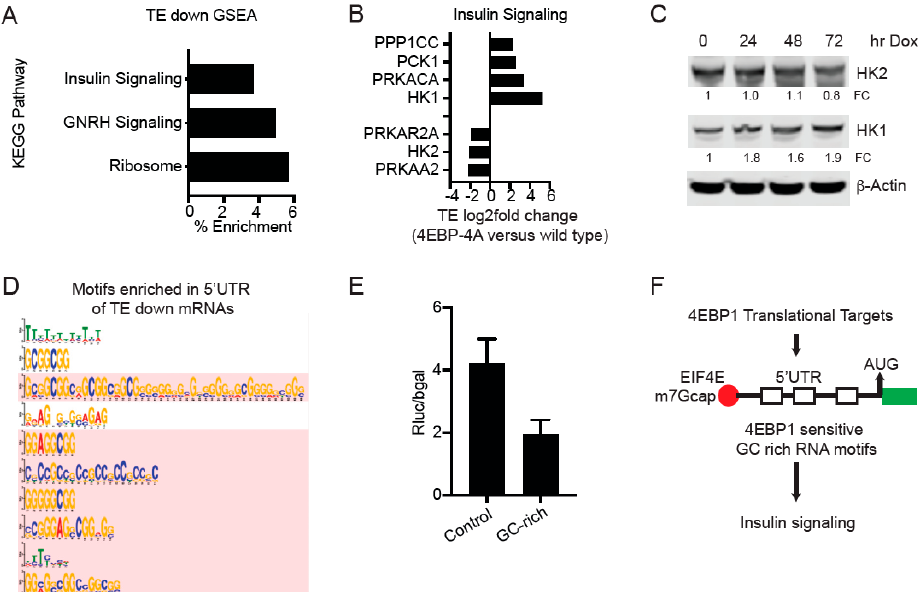
Figure 5. 4EBP1 controls the translation of genes involved in insulin signaling, glucose metabolism, and the inositol pathway. ( A ) GSEA KEGG pathway analysis of 4EBP1-dependent (TE-down) genes. ( B ) TE (log2fold change) of key genes involved in insulin signaling. ( C ) Immunoblot validation translational downregulation of HK2 and upregulation of HK1 protein in a 4EBP1-dependent manner. B-actin was used as the loading control. Quantification of respective proteins is indicated as fold change (FC) normalized to b-actin and untreated cells. ( D ). Conserved RNA motifs enriched in the 5 ′ UTR of mRNA that was downregulated in 4EBP1-4A-mutant-expressing cells compared to the background (Bkg) genes. ( E ) Luciferase assay showing relative translation activity of control (AT-rich) and GC-rich motifs in 293T cells expressing 4EBP1-4A ( n = 6, p < 0.05). ( F ) Diagram showing the regulation of 4EBP1-dependent translation through 4EBP1-sensitive RNA motifs in the 5 ′ UTR. 4EBP1 regulated the translation of key proteins involved in insulin signaling.